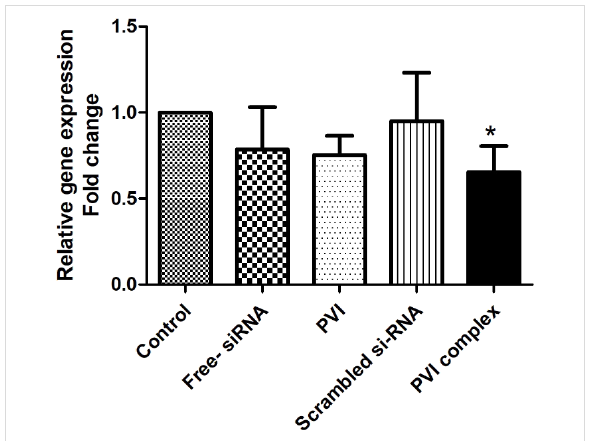
Figure 5: Expression of vascular endothelial growth factor (VEGF) mRNA in A549 cells analyzed by RT-PCR. The fold change was calcu- lated using the ΔΔ Ct method. The results are represented as mean ± SD and analyzed using one-way ANOVA followed by post-hoc Bonferroni comparison test ( n = 3, * p < 0.05) vs